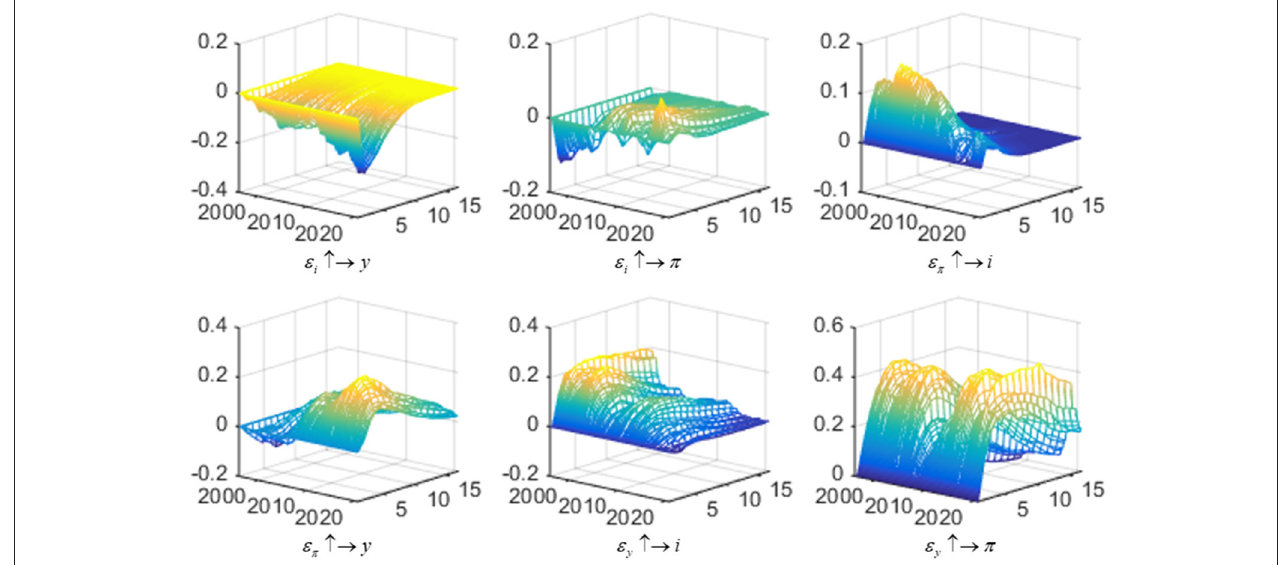
FIGURE 1 | Three-dimensional impulse response of relationships among three variables of China’s monetary policy. Each subfigure with the title of “ X ↑→ Y ” demonstrates the response of variable Y to an orthogonalized positive shock to variable X. In other words, X is an impulse variable, and Y is a response variable. Three variables include interest rate ( i ), inflation gap ( π ), and output gap ( y ). One period in the figure denotes one